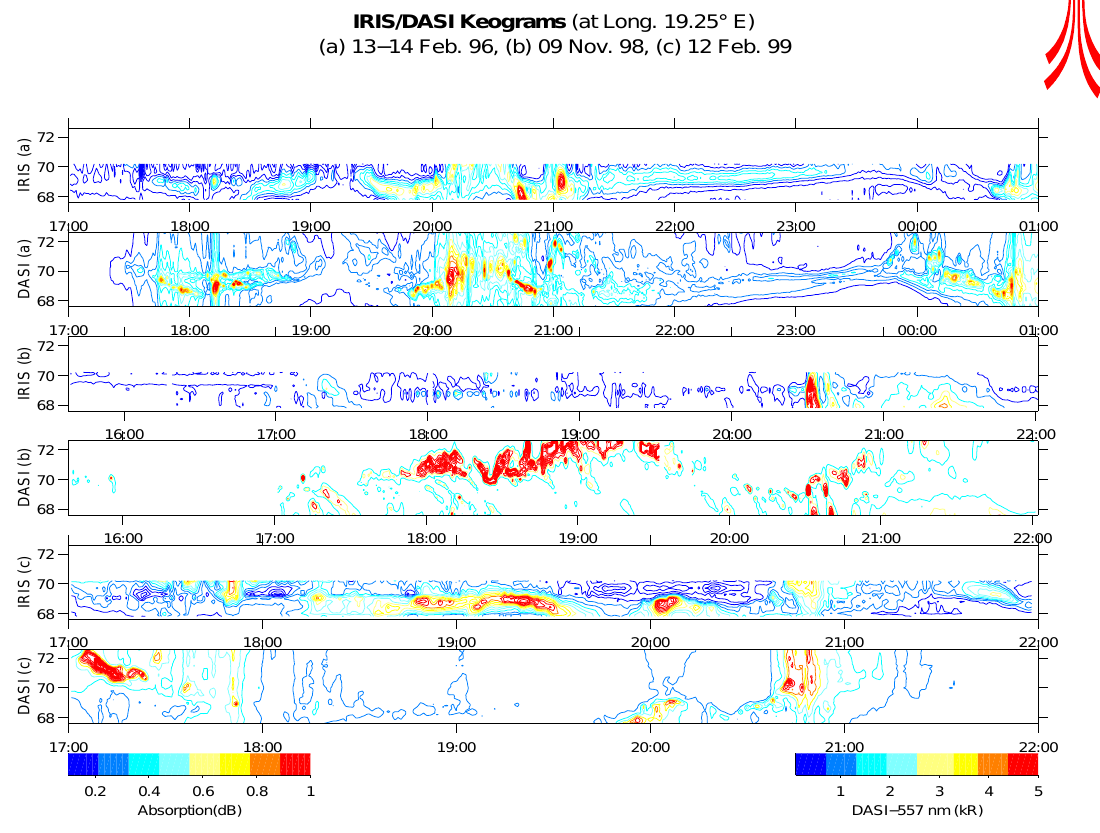
Fig. 1. Keograms at 1min resolution from IRIS absorption and from DASI green-light intensity for observation periods: (a) 17:00–01:00UT, 13–14 Feb 1996, (b) 15:30–22:00UT, 09 Nov 1998, and (c) 17:00–22:00UT, 12 Feb 1999. Colour bars are given on the bottom in dB for the absorption and in kR for the optical